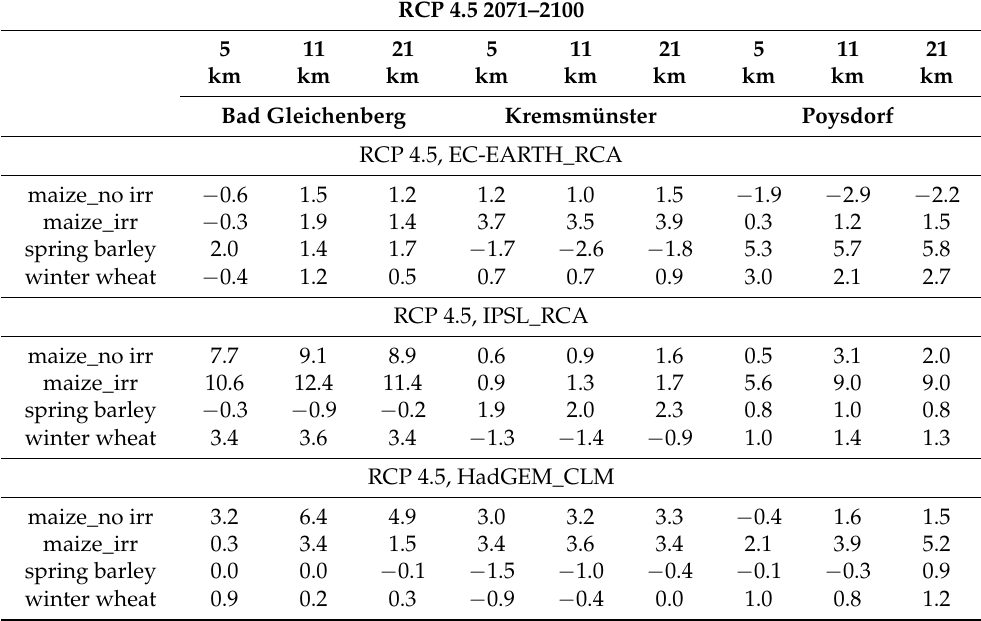
Table 7. Yield differences (%) for maize (rainfed = no irr, optimally irrigated = irr), winter wheat, and spring barley (rainfed) grown on the sandy soil class 1; 1 km input data vs. 5, 11, and 21 km aggregated data for three ÖKS15 projections for RCP 4.5 (EC-Earth_RCA, IPSL_RCA and HadGEM_CLM) for Bad Gleichenberg, Kremsmünster, and Poysdorf for the 2071–2100 period. Differences in percentage for the results with a 1 km